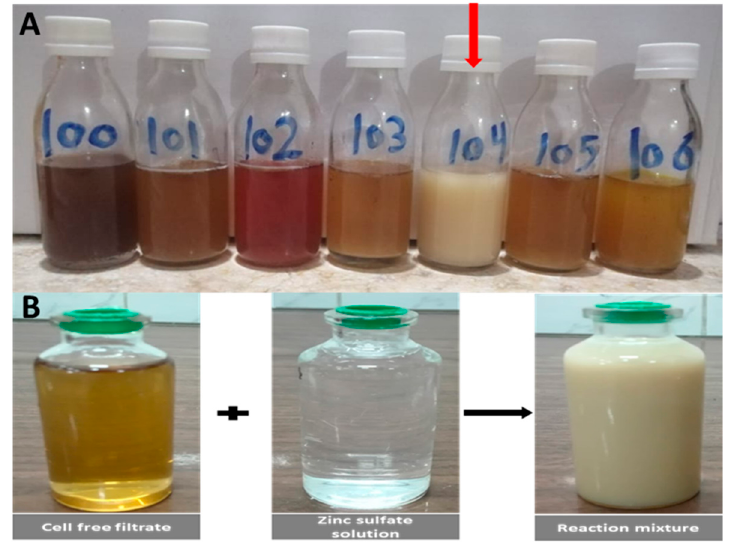
Figure 1. ( A ) Preliminary screening of ZnO ‐ NP synthesis using different cultures of actinomycetes. ( B ) ZnO ‐ NP formation from the CFF of isolate MK ‐ 104 using Zinc sulfate as a precursor.